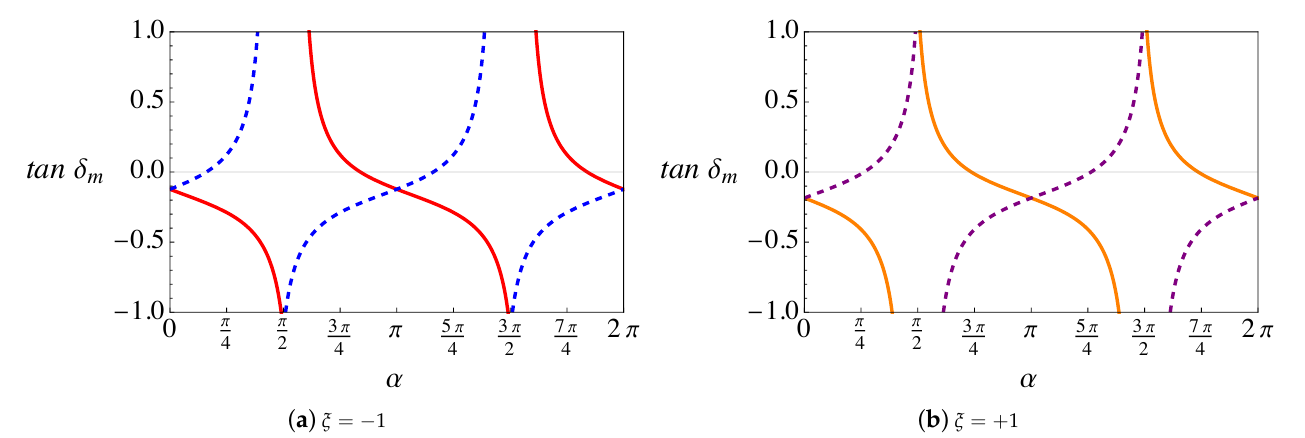
Figure 3. (Color online) Analytical expression for tan δ m (in Equation (S32) of Supporting Information) plotted as a function of α . The plots are computed for a quantum number n = 1, orbital angular momentum m = 1, an external magnetic field B 0 a 2 = 25 ˜ φ 0 and a torsion angle θ = 10 ◦ . ( a ) Node index ξ = 1; the red (solid) line corresponds to a band index λ = 1 and the blue (dashed) line is for λ = − 1. ( b ) Node index ξ = − 1; the orange (solid) line corresponds to a band index λ = 1 and the purple (dashed) line is for λ = − 1.